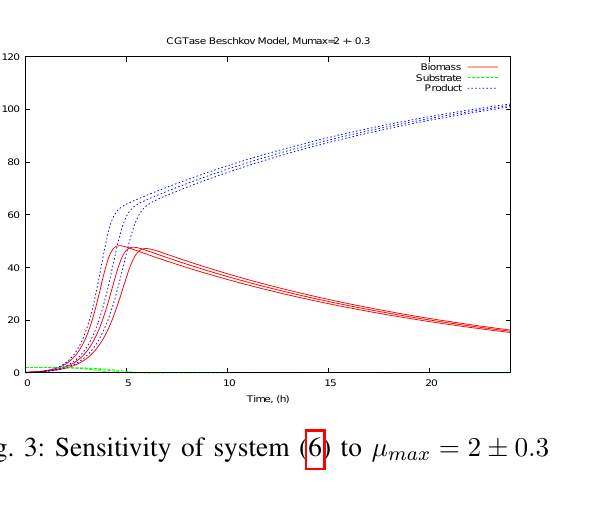
Fig. 2: Sensitivity of system (6) to x 0 = 0 . 2 ± 0 . 1